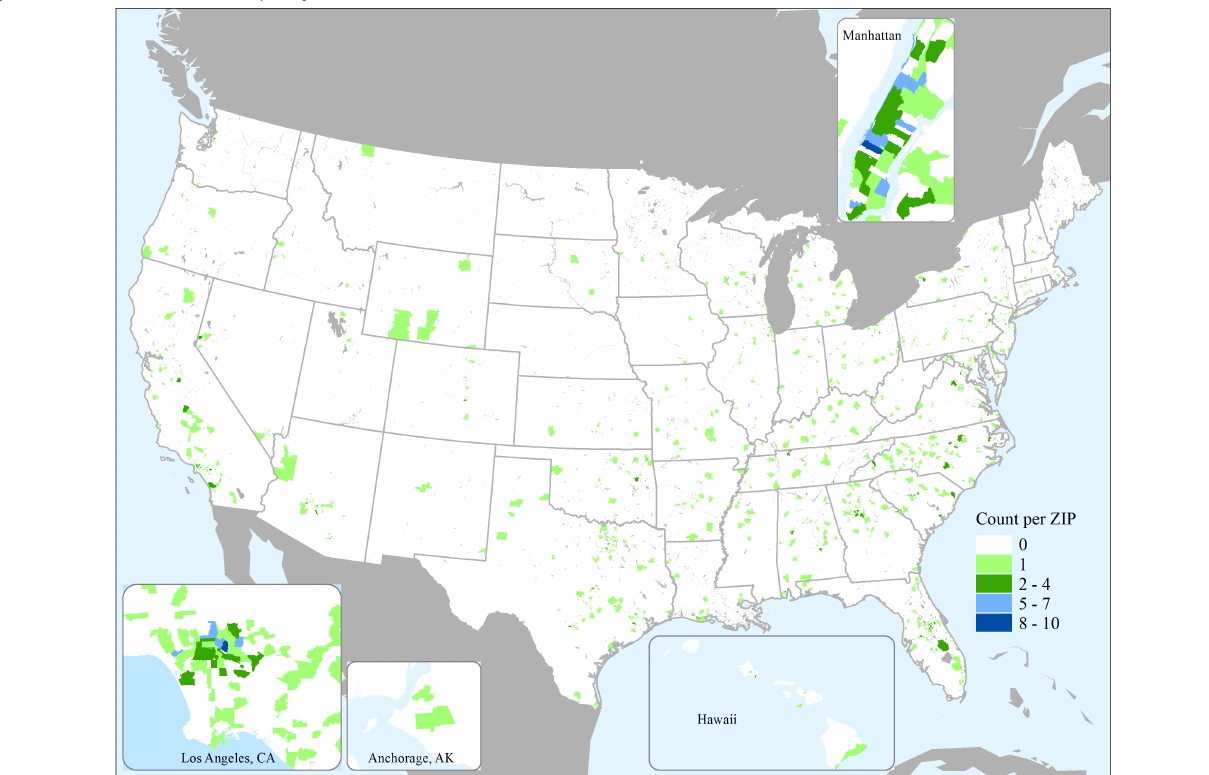
(BMI)—underweight, overweight, or obese versus normal